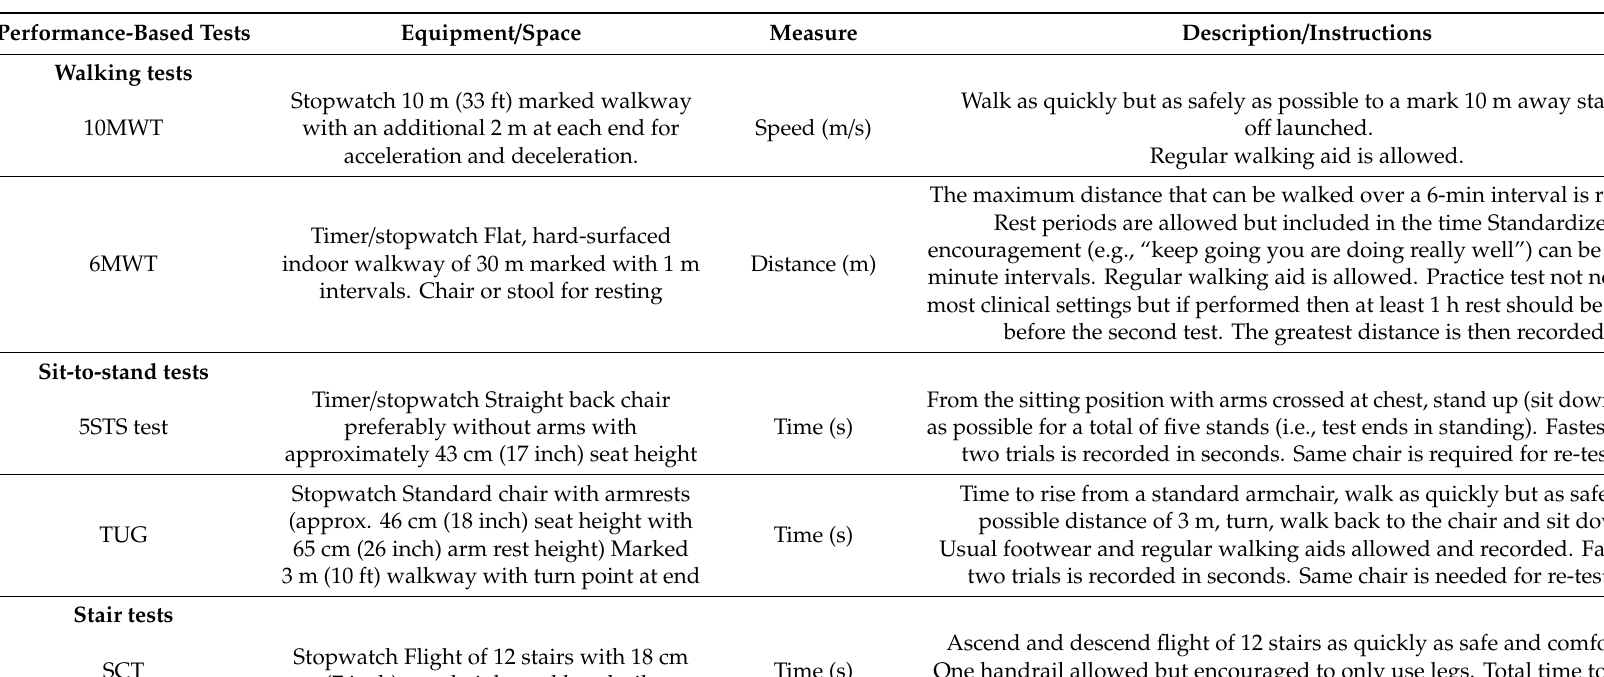
Table A1. Description of performance-based tests of physical